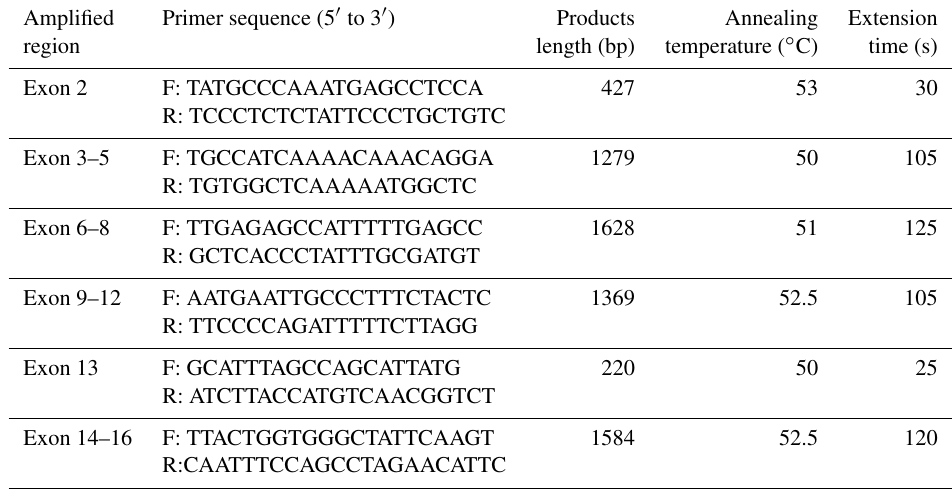
Table 1. Primer information for PCR and polymorphism identification. Amplified Primer sequence (5 (cid:48) to 3 (cid:48) ) Products